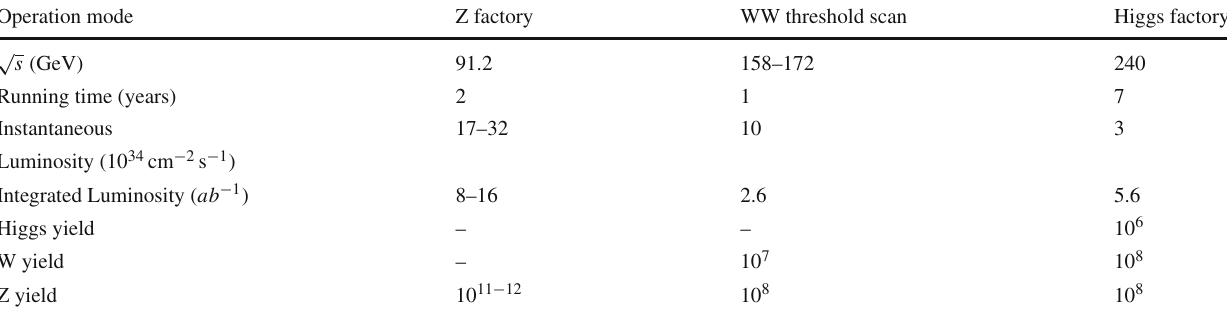
return e + e − → γ Z process. The ranges of luminosities for the Z fac- tory correspond to the two possible solenoidal magnetic fields, 3 or 2 Tesla